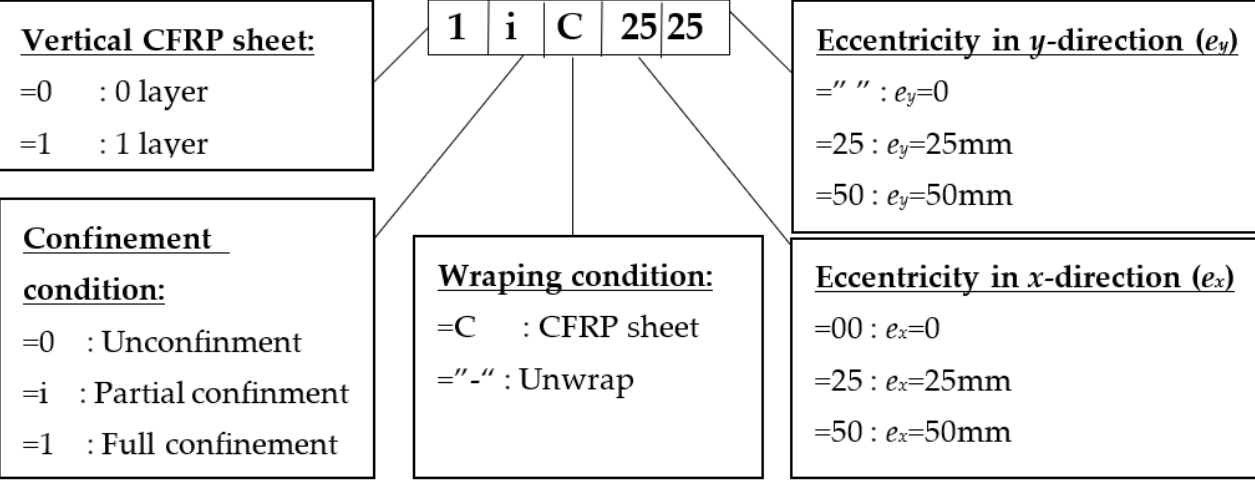
Figure 2. Description of the columns’ name.